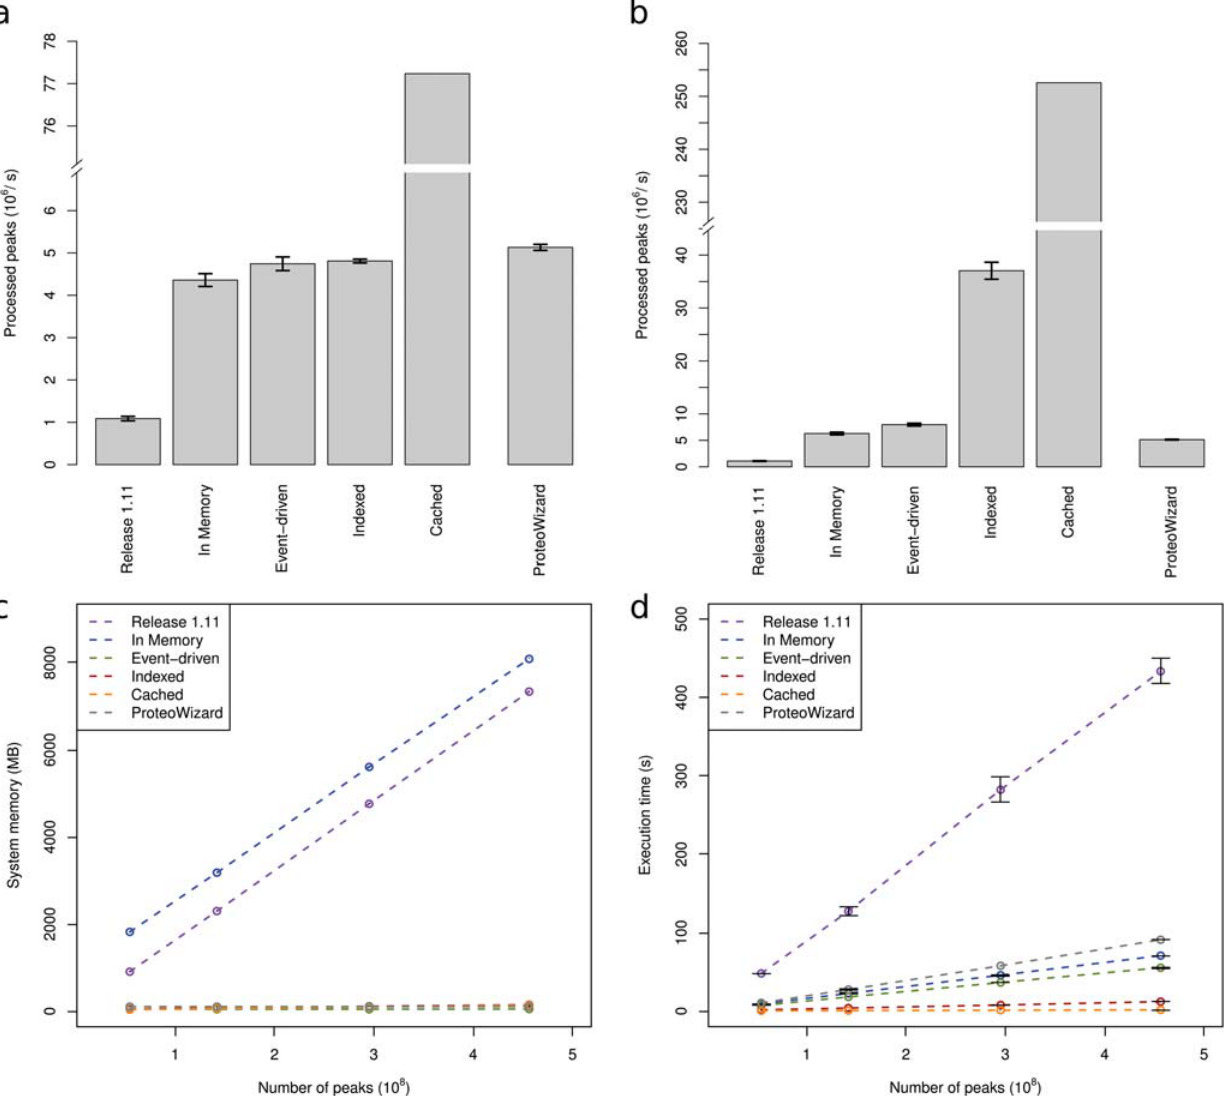
Fig 2. Execution times and memory requirements to calculate the total ion current (TIC) for the described data access implementations. (a)-(b) Processing time normalized to the number of peaks processed per second for the different different implementations using a single thread (a) or up to 16 threads (b). No error bars for “ Cached ” are depicted due to graphical reasons (see S1 Text). For comparison purposes, the previous implementation ( “ Release 1.11 ” ) and the ProteoWizard library also depicted (both only support single-threaded XML parsing). The best performing implementation ( “ Cached ” ) provides a speed-up of more than 200-fold when using multiple threads. (c)-(d) Memory requirements (c) and execution times (d) as a function of the number of peaks for the different algorithms. While runtime scales linearly for all algorithms, the “ event-driven ” and “ cached ” algorithms have constant memory requirements. The implementations were allowed to use parallel processing (up to 16 threads). Comparisons were performed using the TICCalculator and files described in the